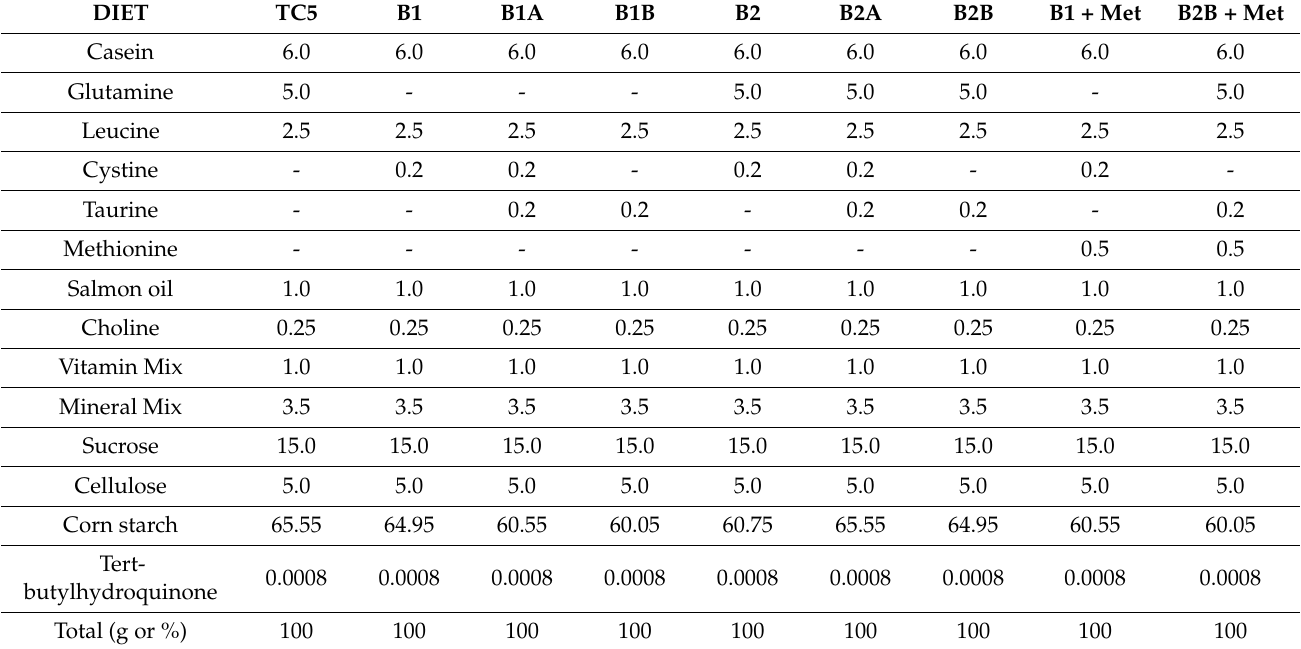
Table 5. Composition of the artificial diets used in this work (g/100 g